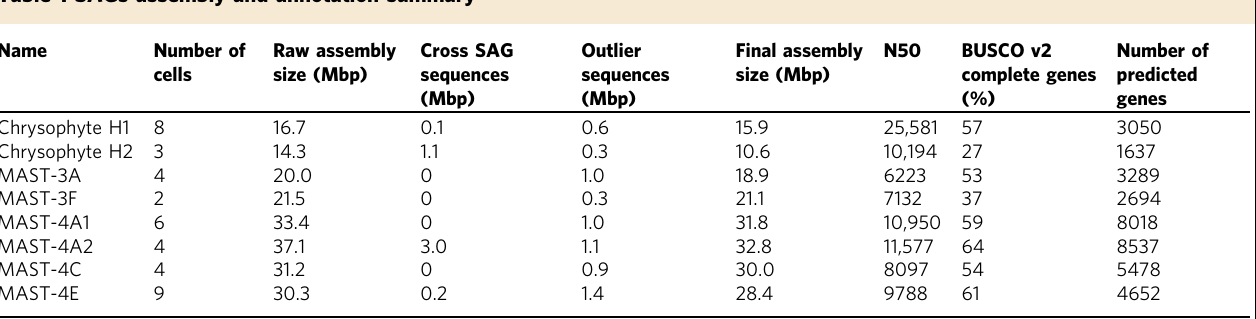
Table 1 SAGs assembly and annotation